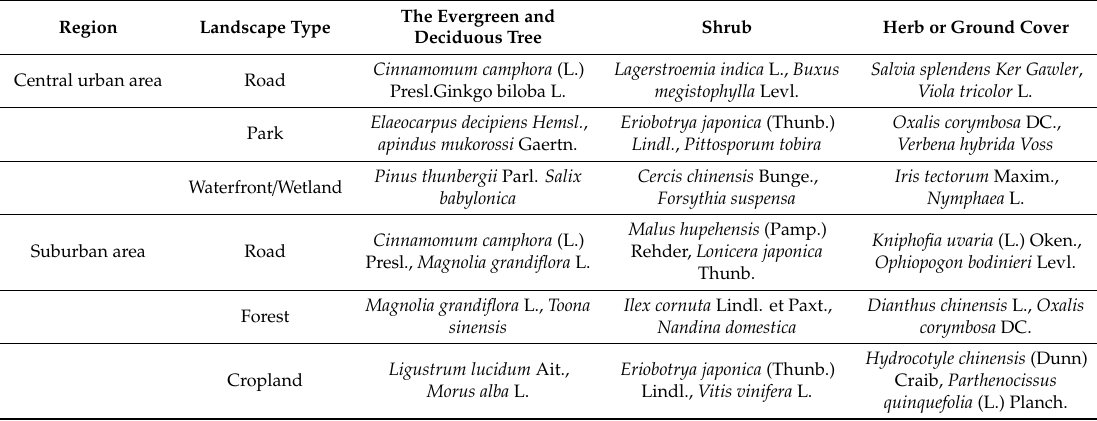
Table 5. Corridor landscape type and plant community configuration